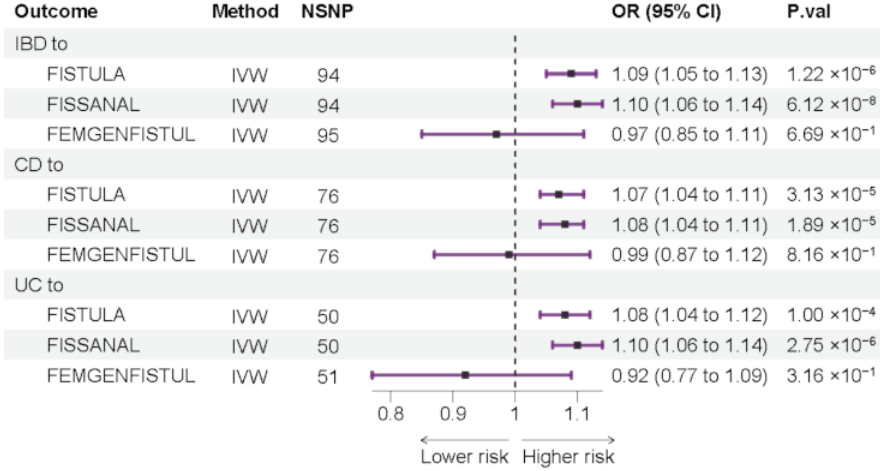
Figure 2. Mendelian randomization (MR) results of IVW. Causal estimation of IBD effects on fistulas (IBD: inflammatory bowel disease; UC: ulcerative colitis; CD: Crohn’s disease; FISTULA: colonic or urogenital fistula; FISSANAL: fissure and fistula of anal and rectal region; FEMGENFISTUL: fistula involving female genital tract; NSNP: the number of single nucleotide polymorphisms used in MR analysis; OR: odds ratio; CI: confidence